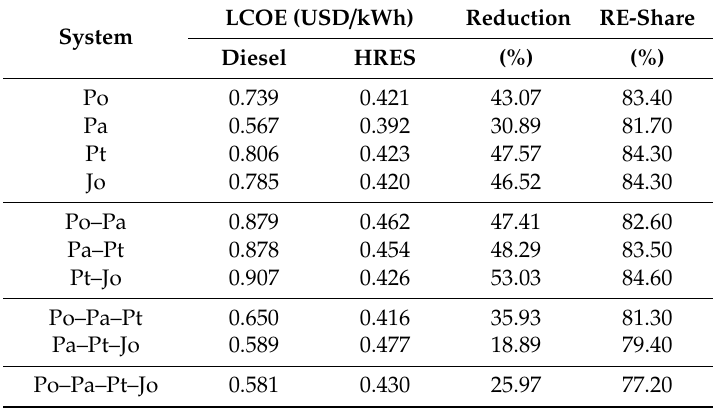
Table A1. Comparison of diesel-only systems and